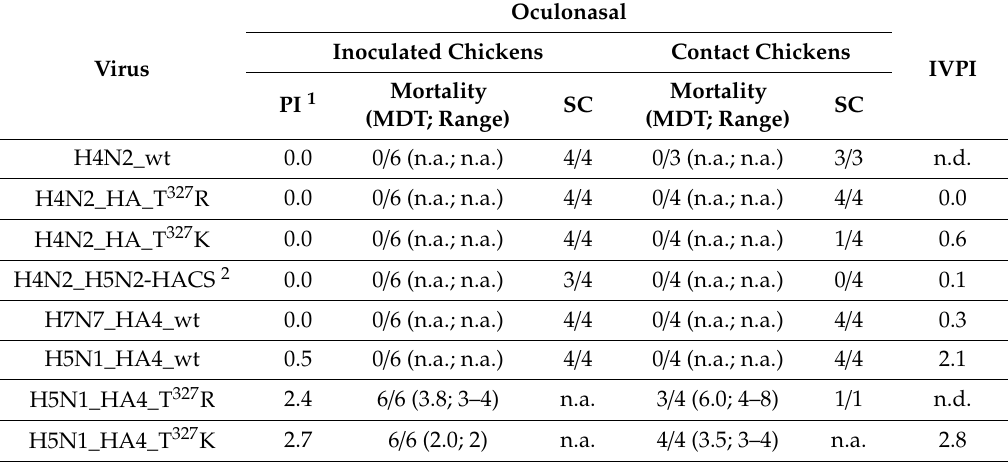
Table 2. Results of the clinical examination after the challenge of chickens with di ff erent recombinant viruses in this study.